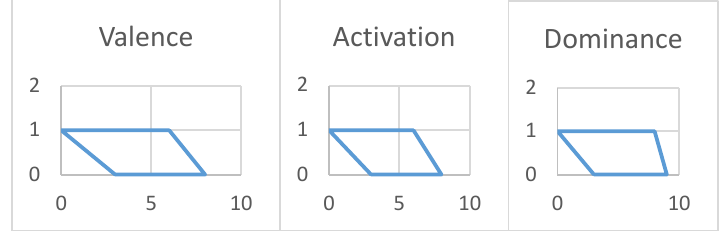
Fig. 15. The FOU of Egwu (Dread) for dimensions valence, activation and dominance.